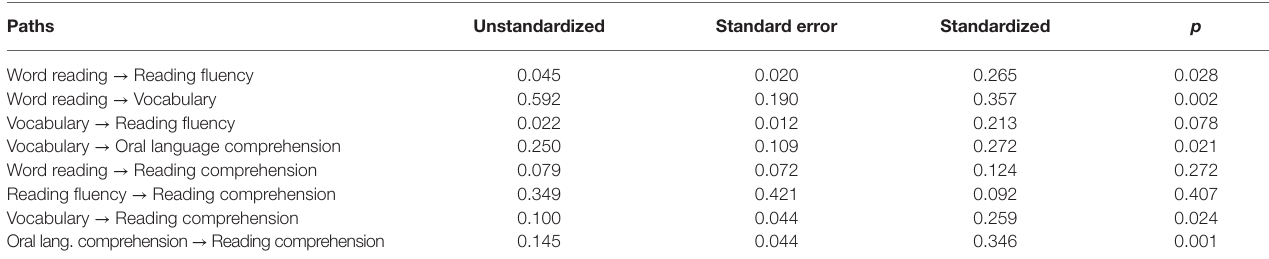
TABLE 2 | Unstandardized and standardized path coefficients for the extended SVR model.